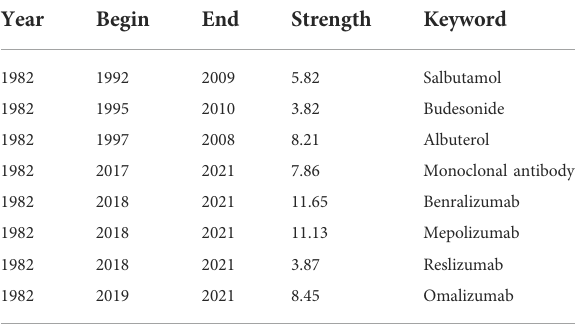
TABLE 6 Keywords of asthma drug with strongest citation bursts in severe asthma drug-related studies. Year